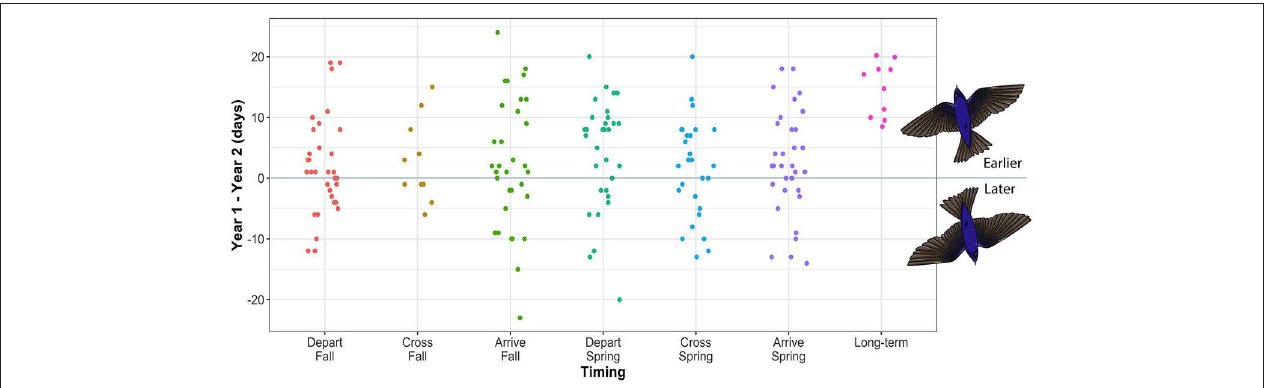
FIGURE 2 | The difference in migration timing between year one and year two for individual purple martins tracked between North American breeding and South American overwintering sites. A positive value indicates earlier timing in the second year of tracking. Sample sizes for each timing category are as follows: depart fall = 32, cross fall = 10, arrive fall = 32, depart spring = 32, cross spring = 28, arrive spring = 33. Data show timing at migration start and end points, as well as the timing of crossing the Tropic of Cancer (23.4 ◦ N), in both spring and fall. Long-term data for mean breeding arrival date in spring across the range (from Arab and Courter, 2015) are included to enable comparison of these longer-term advances in timing over 100 years with short-term differences at the individual level (this